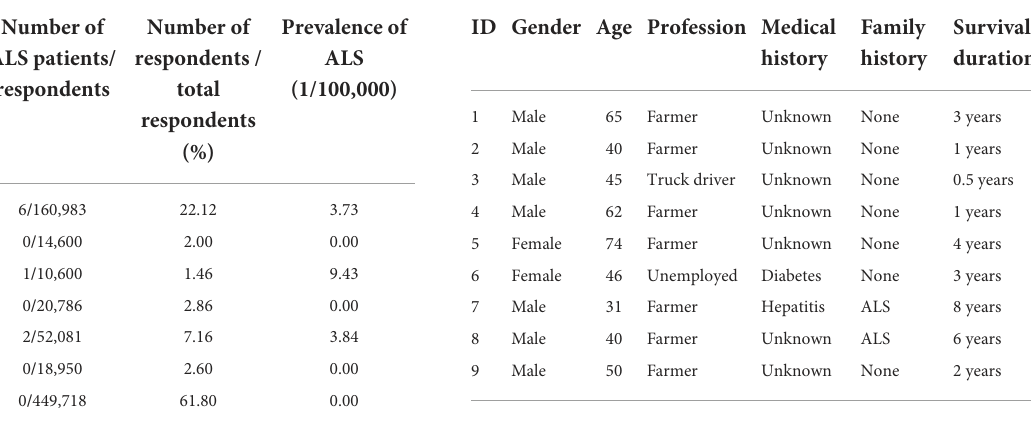
TABLE 1 Prevalence of ALS in 7 provinces of China mainland in population survey.